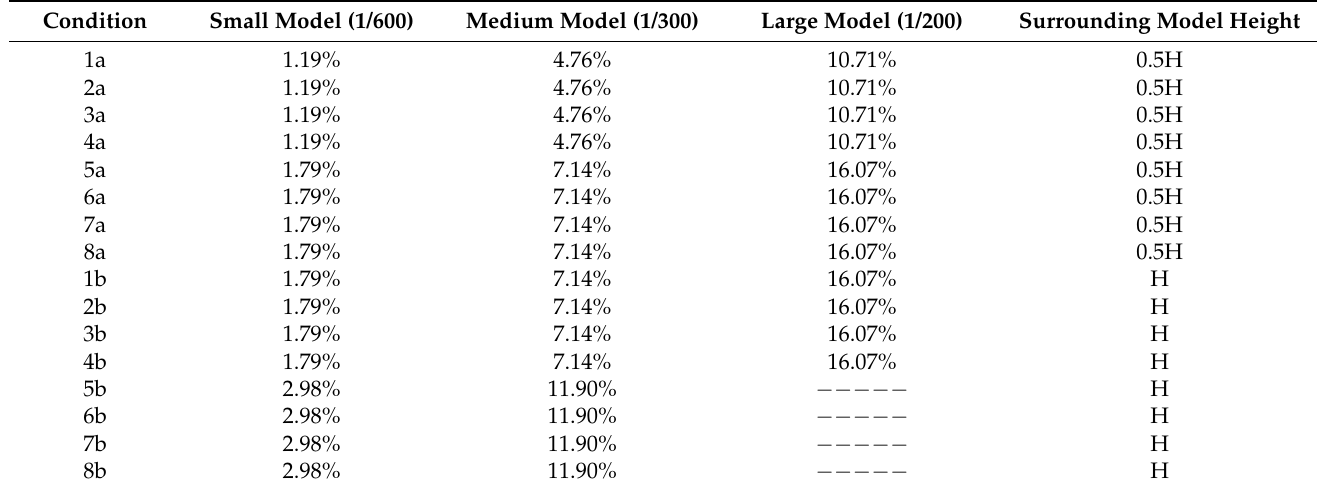
Table 2. The blockage ratio of each test condition.